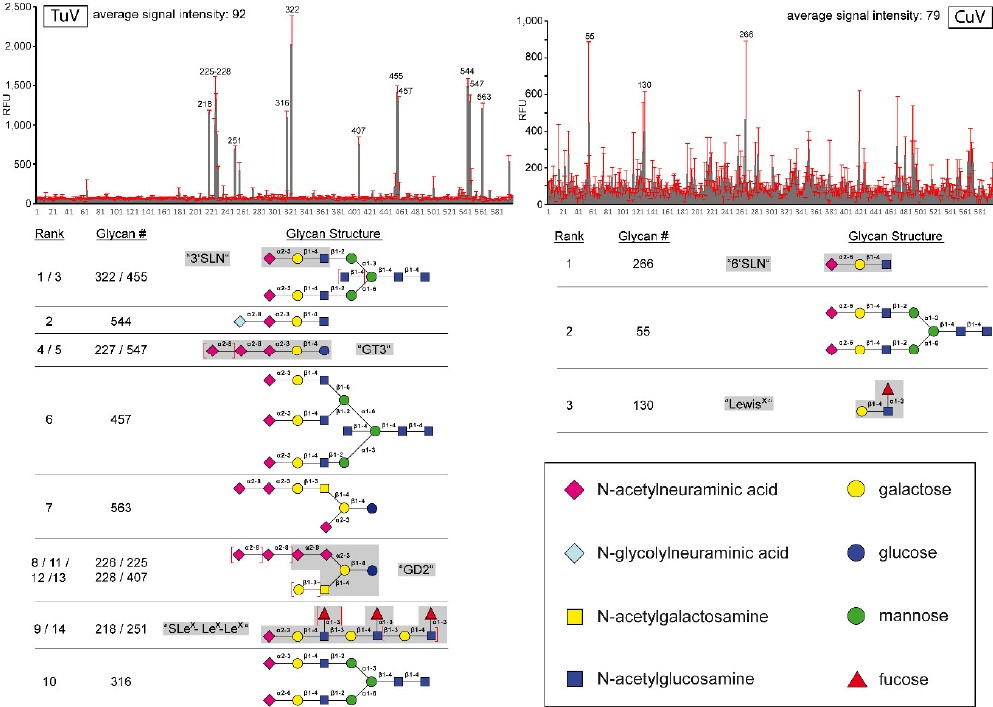
Figure 6. Glycan array of CuV and TuV. Relative fluorescence units (RFU) versus glycan number for TuV (top left) and CuV (top right) VLPs. 600 different glycan molecules (CFG glycan array v5.2) were screened. The gray bars represent the fluorescence detected for each glycan with the standard deviation shown in red. Below each histogram are symbol representation of the glycans with the highest signals. Trivial names of glycans are given where available. The definition of each symbol is provided on the bottom right hand side.